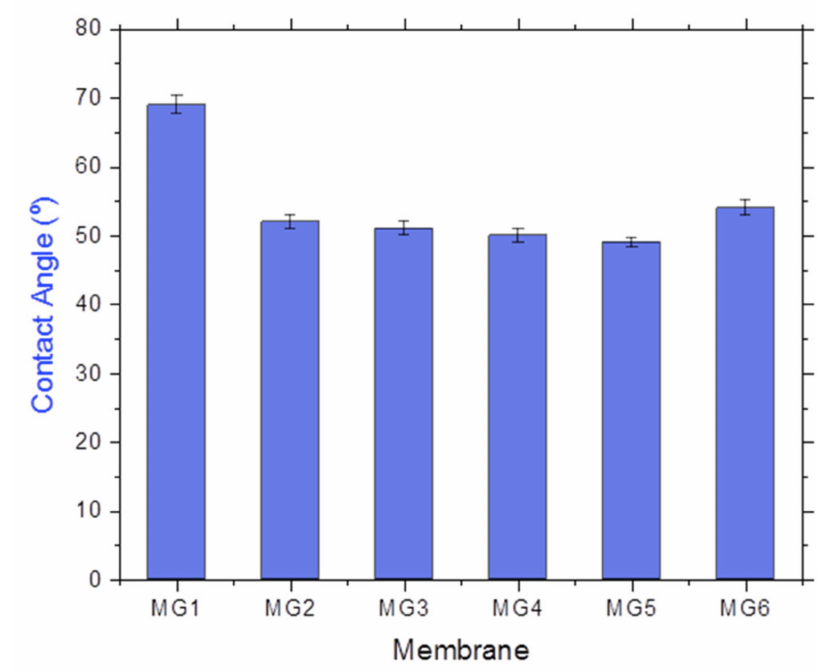
Figure 4. Contact angle measurements of synthesized